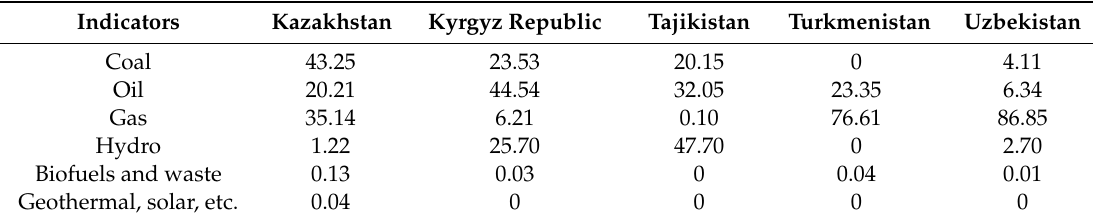
Table 6. Total Primary Energy Supply (TPES) by source, 2016, % (Source: author, based on IEA World Energy Balances 2018).